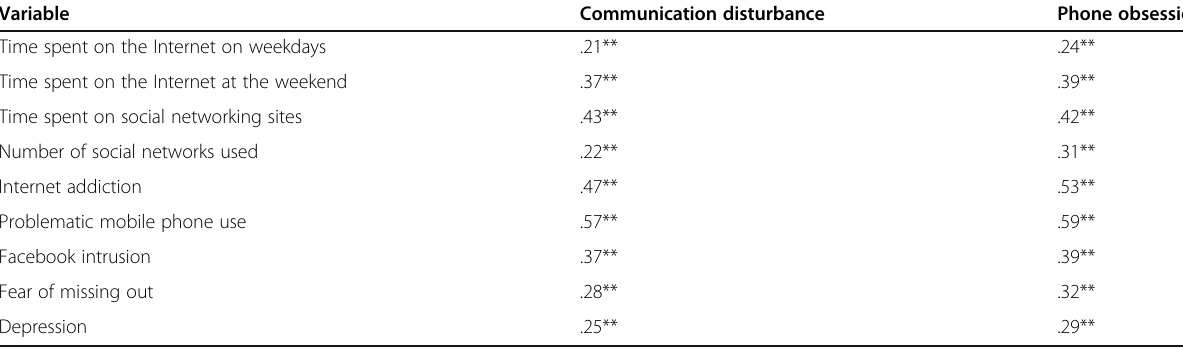
Table 5 Correlations of PS-8 scores with scores on the other variables